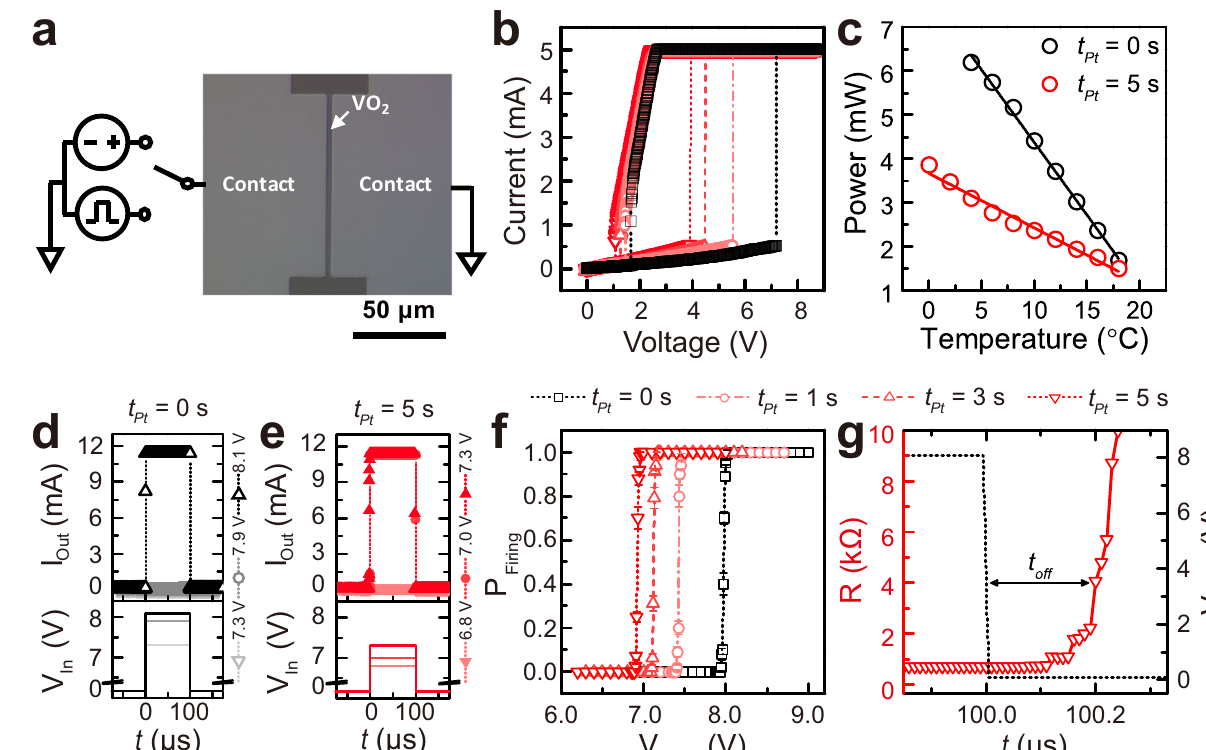
Fig. 2 | Current – voltage characteristics oftwo-terminalVO 2 Mottswitchesas a function of Pt NP coverage. a Schematic representation of the voltage-triggered insulator-to-metal transition (IMT) measurement setup and optical microscope image of VO 2 Mott switch with 5 μ m electrode separation and 100 μ m electrode width.TheperformanceofVO 2 -basedthresholdswitcheswasmeasuredwitheither a continuous voltage sweep or an ultrafast voltage pulse. b Continuous voltage sweep of all two-terminal devices with Pt-NP-embedded epitaxial VO 2 fi lms. c The power to turn on a threshold device with t Pt = 0s and 5s. Solid lines are the linear best fi ts to the data, which were extracted from Supplementary Fig. 6. d The